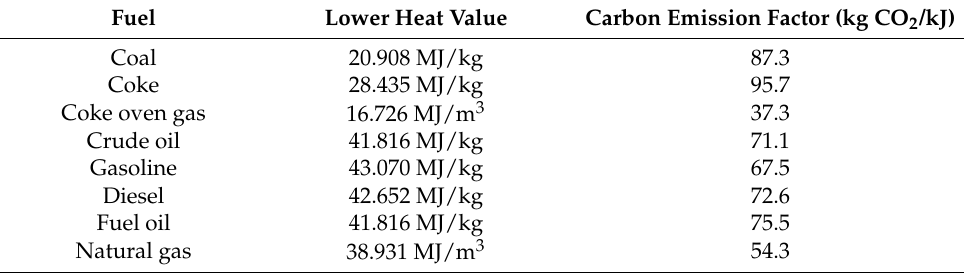
Table A3. Carbon emission factor of different energy.